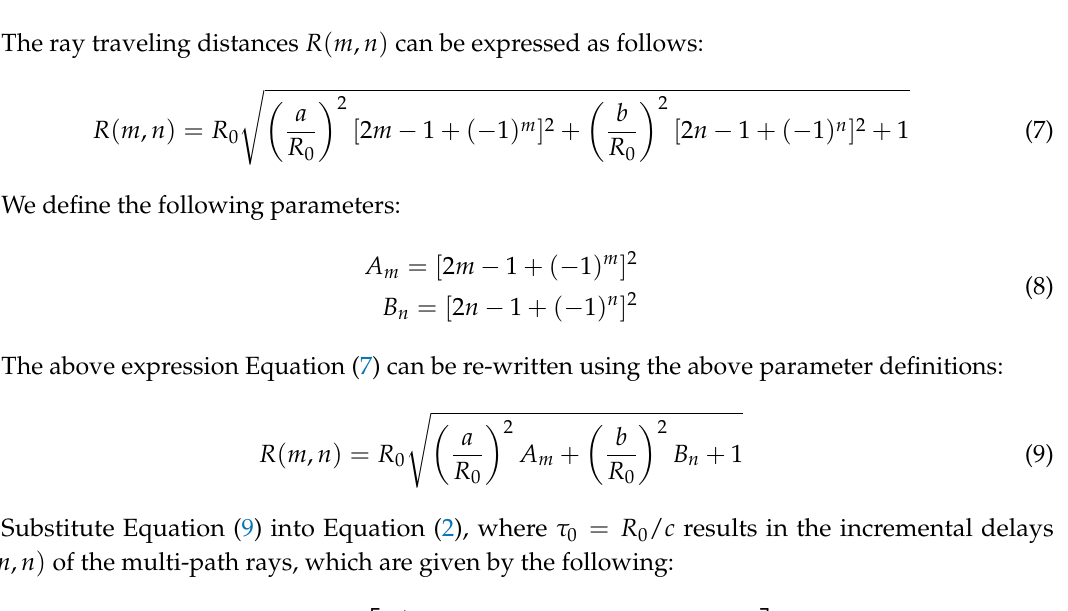
Figure 2. Reflection coefficients for different construction materials at 28 GHz: ( a ) transverse electric (TE) reflection; ( b ) transverse magnetic (TM)